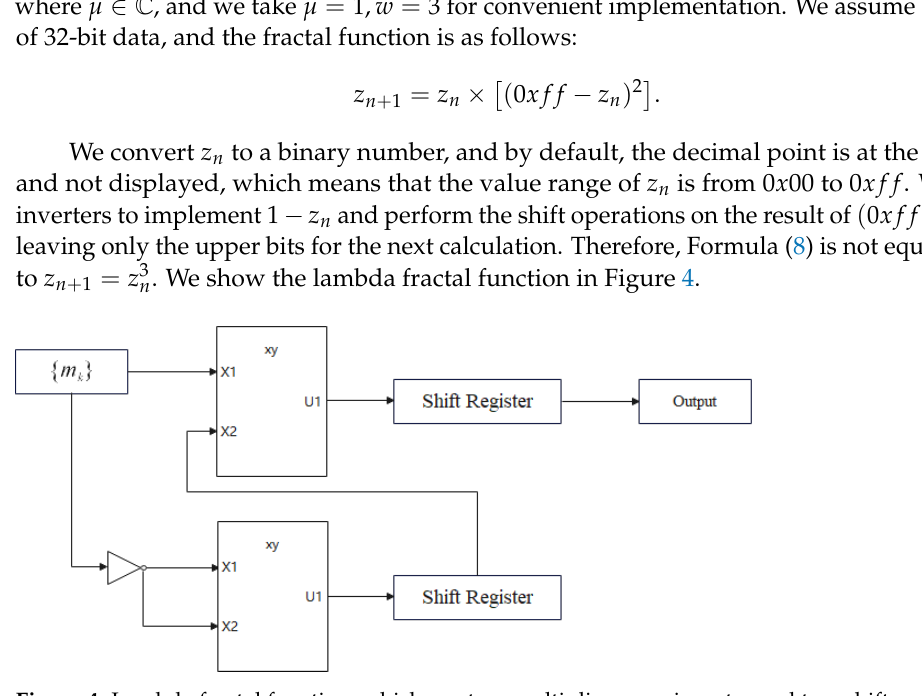
Figure 4. Lambda fractal function, which use two multipliers, one inverter and two shift registers. The output sequence is also reserved for high bits, which is consistent with the length of sequence b k . We use Algorithm A1 to describe the fractal function in the Appendix